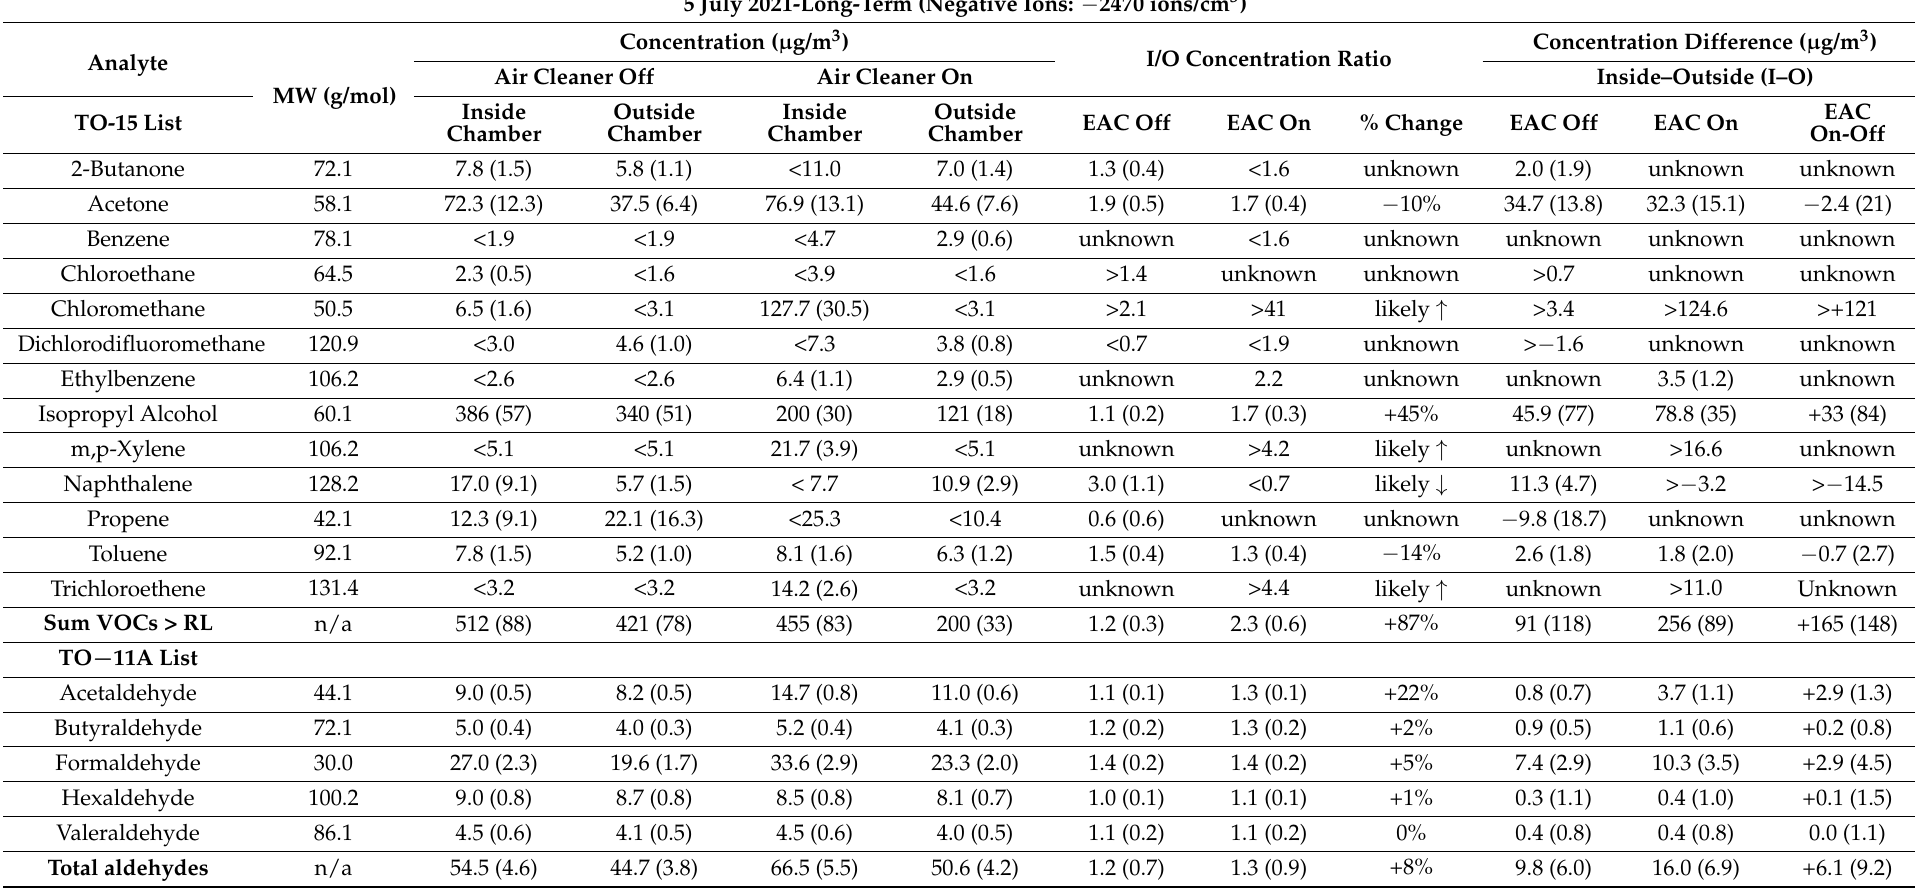
Table A3. Resulting concentrations and calculated inside/outside (I/O) chamber concentration ratios for TO-15/TO-11A analytes above reporting limits (RL) in at least one air sample from the 5 July 2021 long-term natural condition test. Symbols “likely ↑ ” and “likely ↓ ” denote likely, albeit not directly quantifiable, increases and decrease,